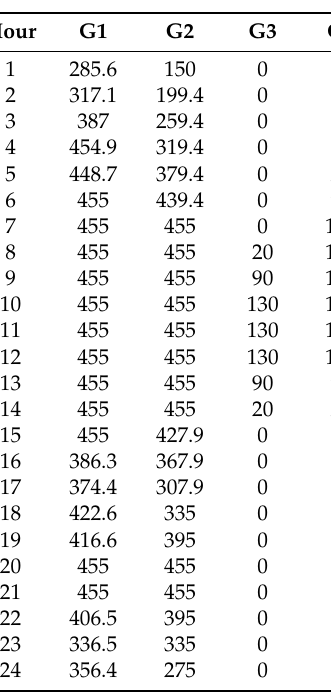
Table 3. Conventional units output (Case 3).